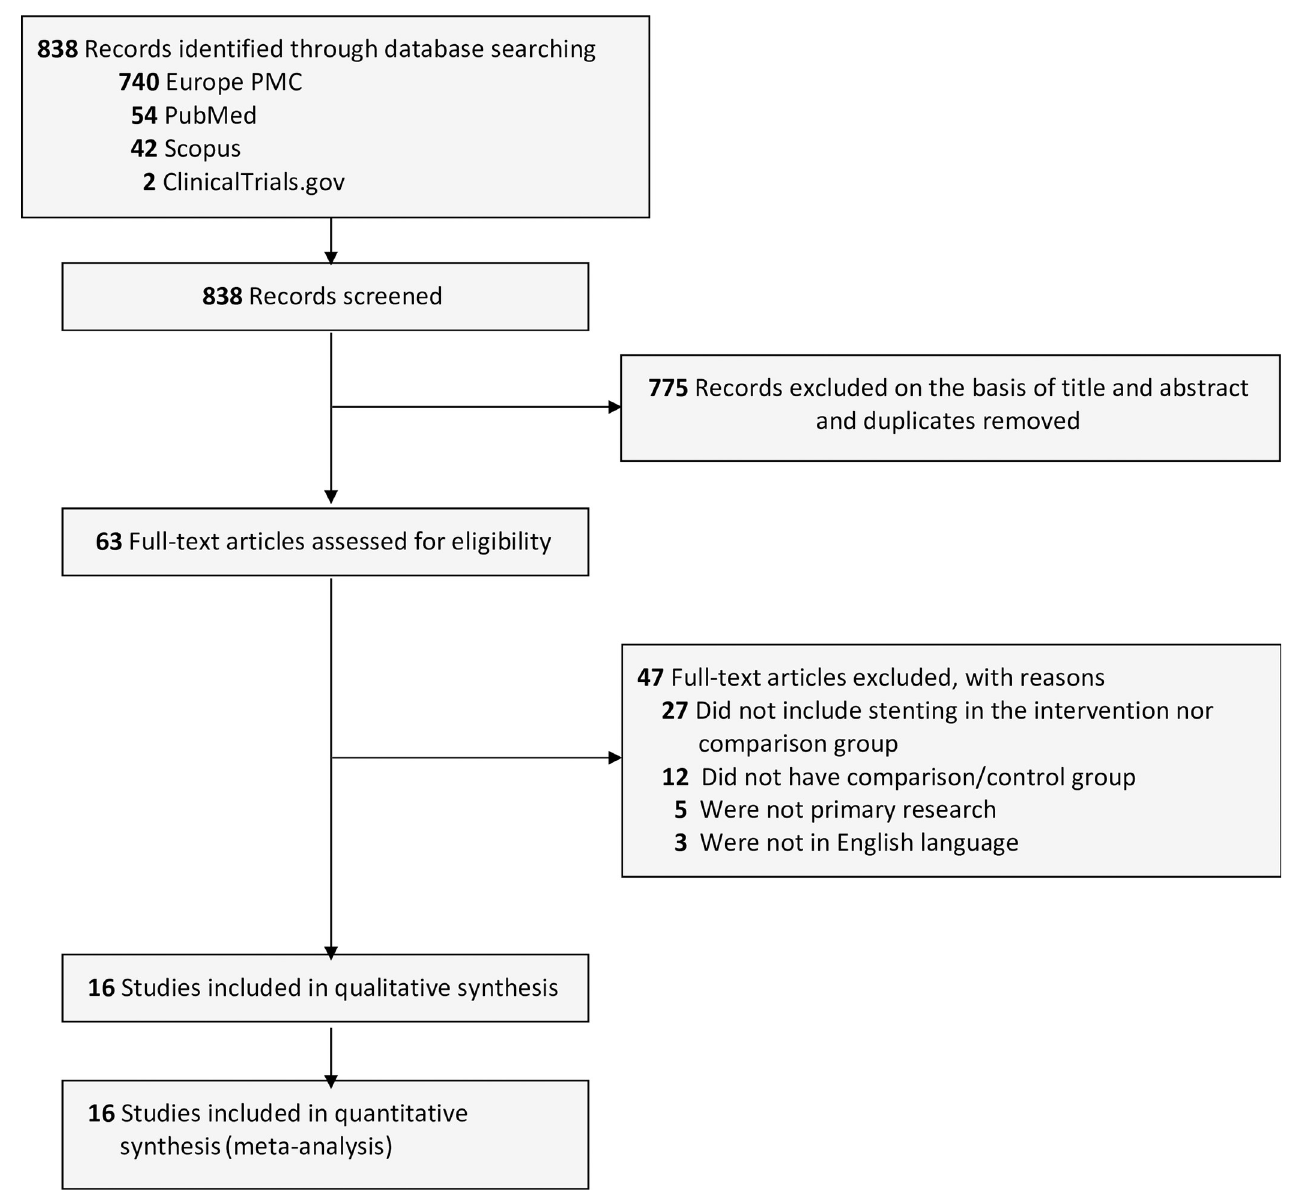
Fig 1. The PRISMA flowchart of the studies selection process. https://doi.org/10.1371/journal.pone.0280755.g001 Wound infection. In the pooled analysis of six studies (n = 269), biliary stenting and T- tube drainage after CBD exploration did not demonstrate any differences in wound infection outcome [RR 0.37 (95% CI 0.12–1.13), p = 0.08, I 2 = 12%, random-effect modeling] (Fig 2B). Pancreatitis. In the pooled analysis of eight studies (n = 363), the pancreatitis incidence after CBD exploration did not differ between biliary stenting and T-tube drainage [RR 0.55 (95% CI 0.13–2.28), p = 0.41, I 2 = 41%, random-effect modeling] (Fig 2C). Overall postoperative complications. In the pooled analysis of 16 studies (n = 1,080), the overall postoperative complications were lowered in the biliary stenting group than in the T- tube group after CBD exploration [RR 0.43 (95% CI 0.23–0.80), p = 0.007, I 2 = 63%, random- effect modeling] (Fig 2D).